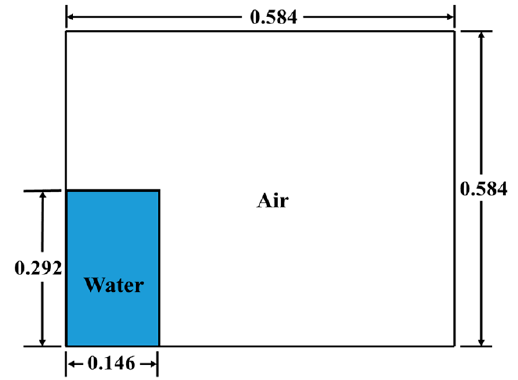
Figure 2. Dam break foundation calculation